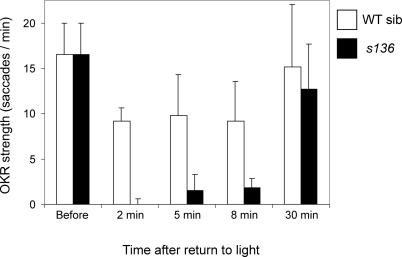
Example of a Mutant with a Potential Defect in Light AdaptationOKR is plotted at several time points before and after dark treatment for 45 min. WT sibling larvae (n = 6) recover quickly from the dark pulse, while nkis136 mutants (n = 6) show reduced responsiveness for several minutes after return to the light. Average number of saccades to a constant motion stimulus is shown for each time point. Error bars indicate standard deviation.